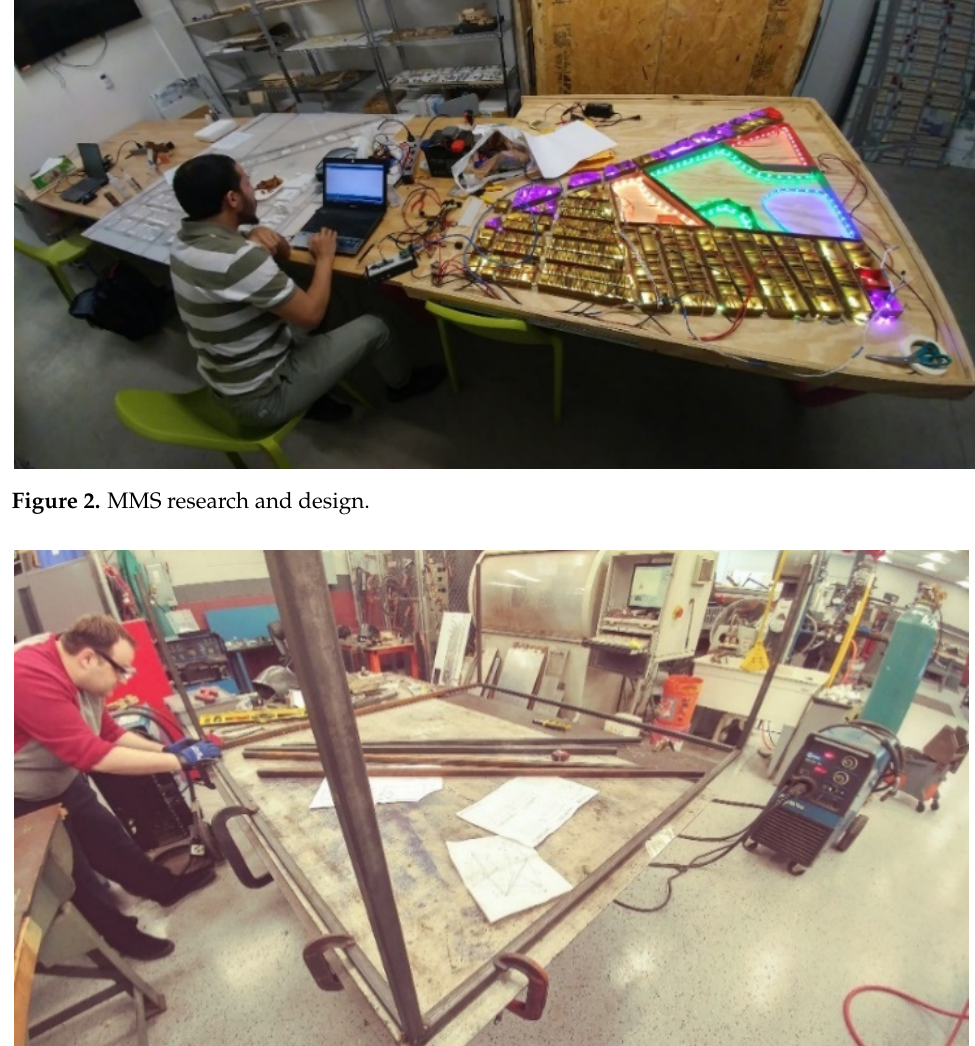
Figure 3. MMS construction.